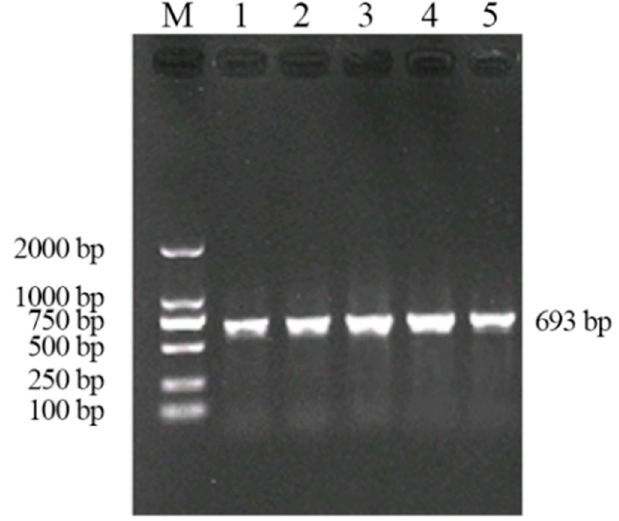
Figure 2. Optimization of the annealing temperature for the primer AP1-1/AP1-2. M: DL 2000 DNA marker; 1–5: annealing temperatures of 57, 58, 59, 60, and 61 °C, respectively.